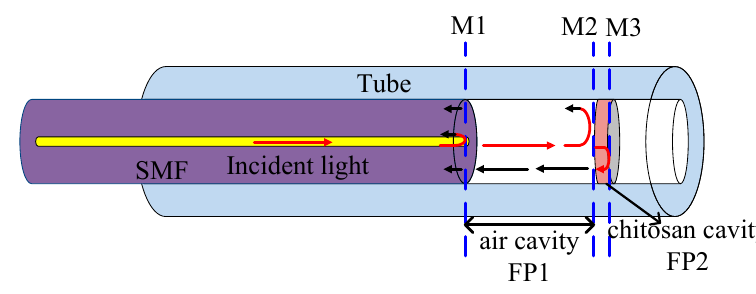
Figure 2. Schematic diagram of the proposed HVE FPI sensor.